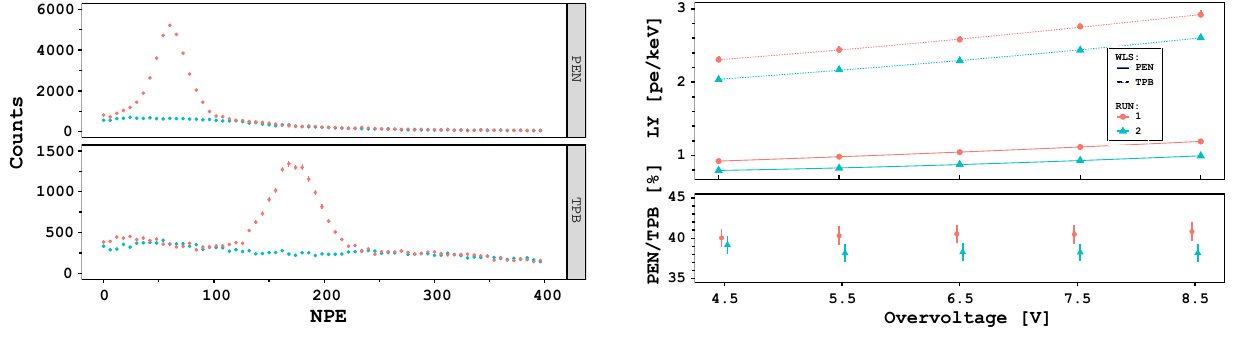
tored into the reported light yield as a correction for the raw charge spectrum of the interested photo-detector. This cor- rection increases the LY of the TPB chamber by